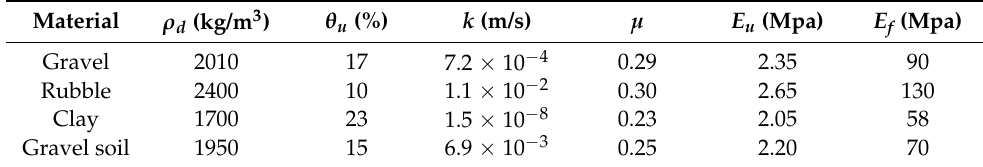
Table 1. Physical parameters in the permafrost subgrade